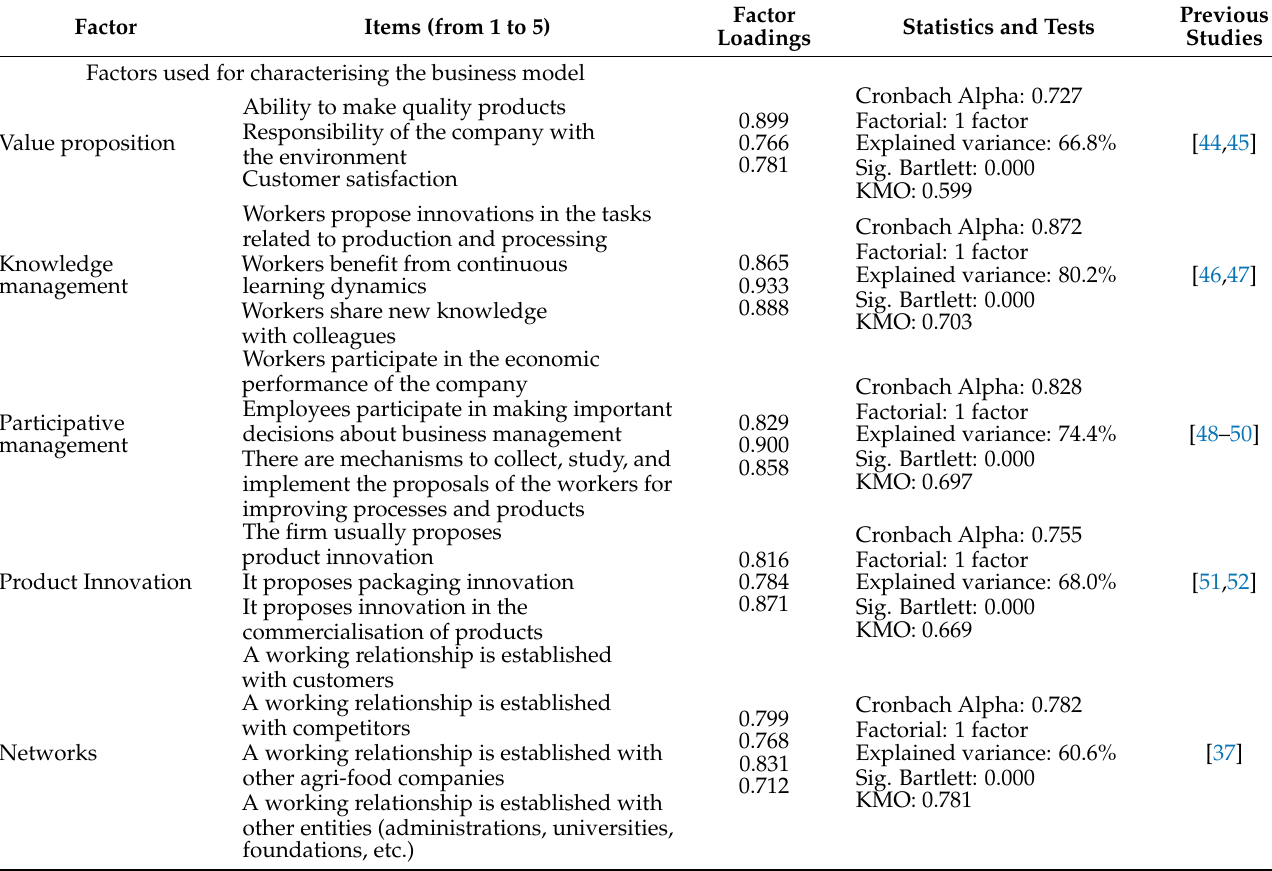
Table 2. Constructs used in the